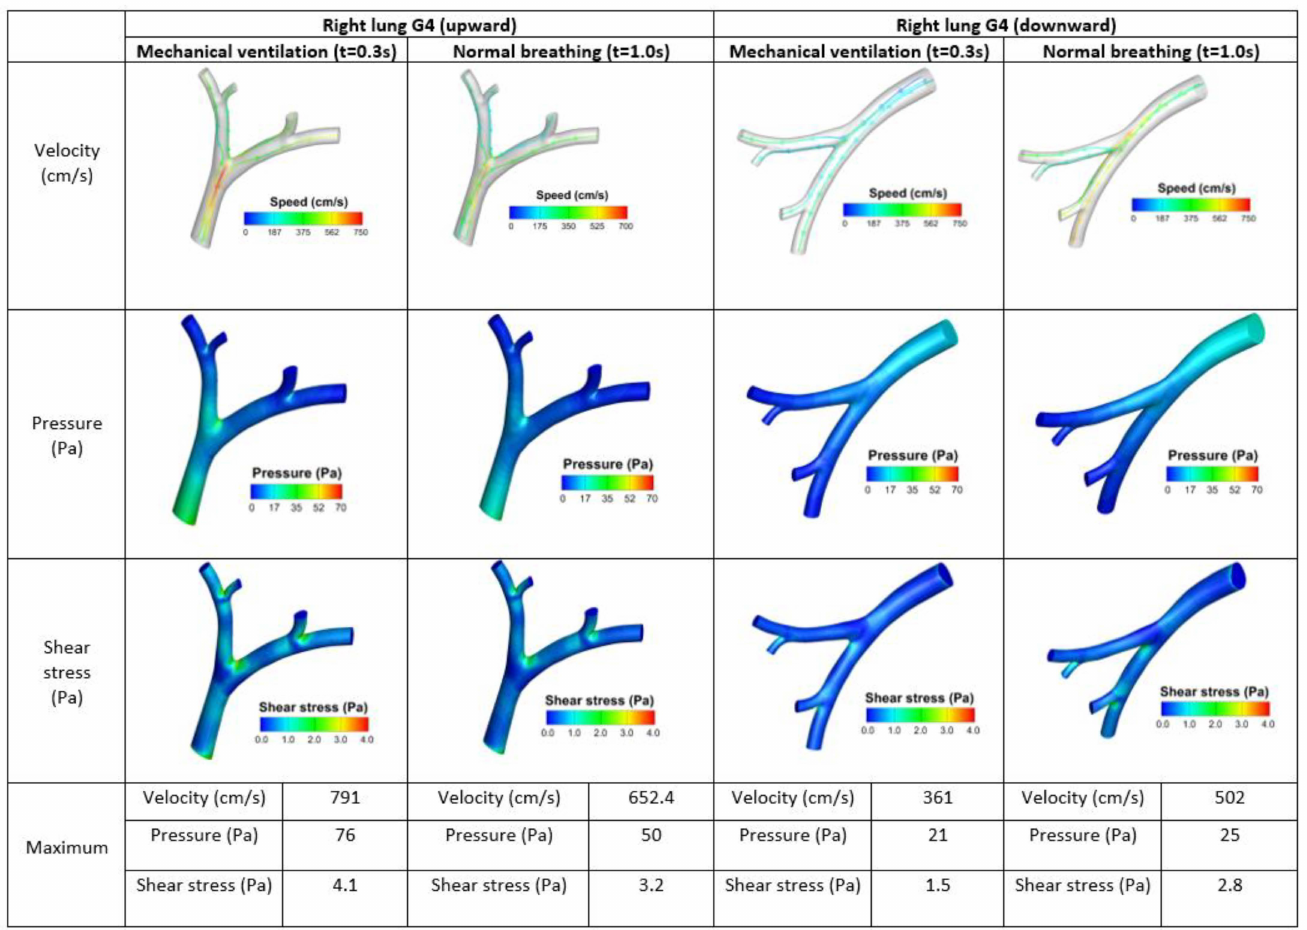
Figure 14. Comparison of simulations for the upward and downward G4 bifurcation. Comparison of the maximum velocity, pressure, shear stress, values at the upward and downward fourth generation local bifurcations of the right lung for MV and the